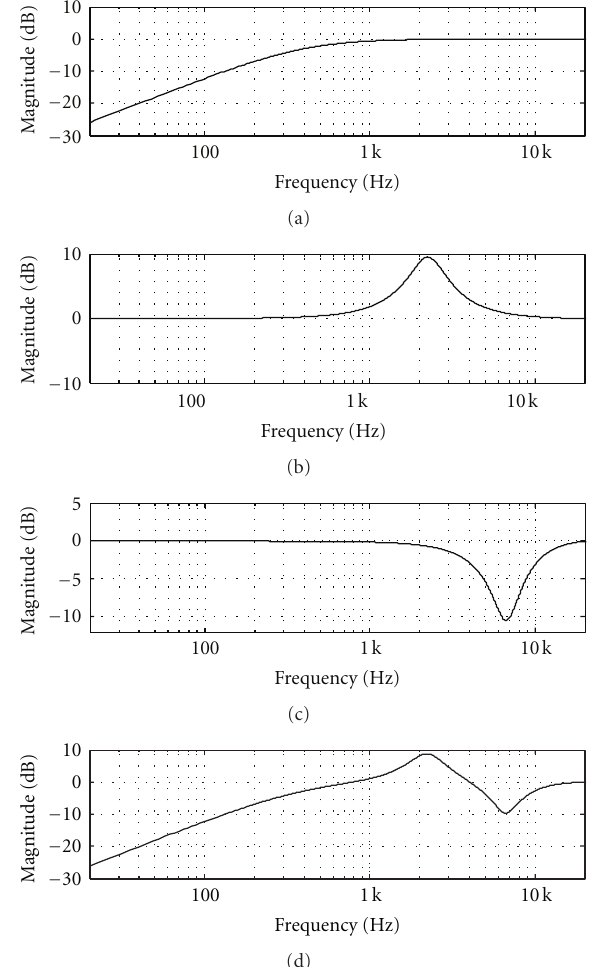
Figure 12: Magnitude frequency responses of the digital filters in the ARA equalizer: (a) the first-order Butterworth highpass filter, (b) the biquad peak filter, (c) the biquad notch filter, and (d) the combined response of the three